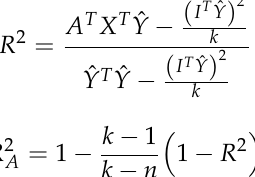
Table 1. The scenarios and results of numerical simulations. Working Parameters Test Results Half Cone Angle 𝚽 (°) Taper Angle of Pick Body 𝒈 (°)